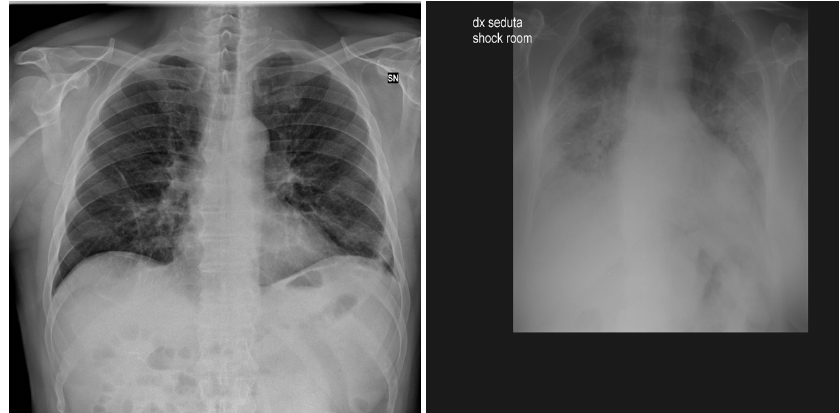
Figure 6. Examples of COVID-19 RADIOGRAPHY images [42].